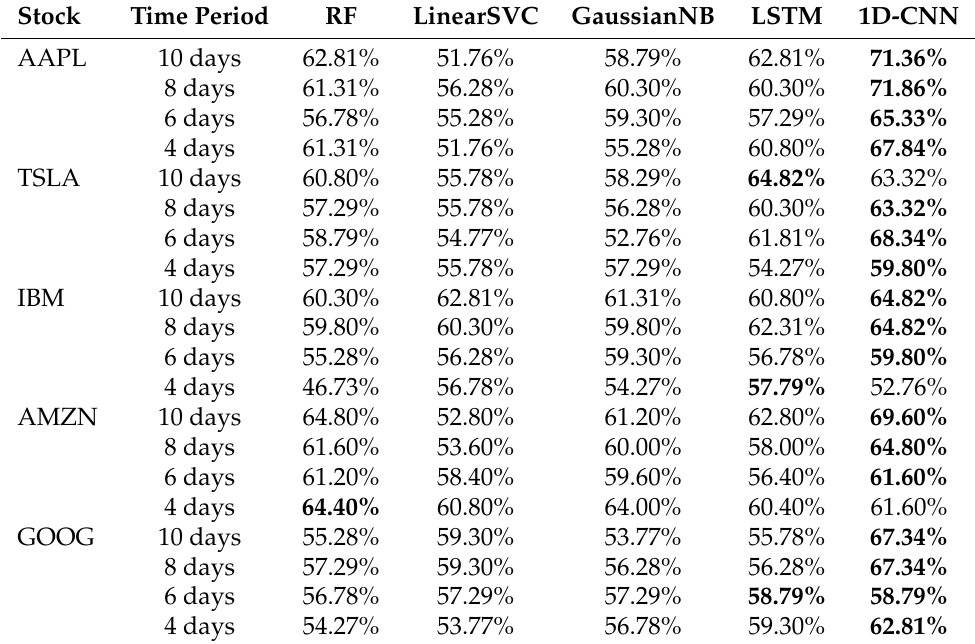
Table 4. Accuracy improvement of stock trend prediction based on sentiment analysis and